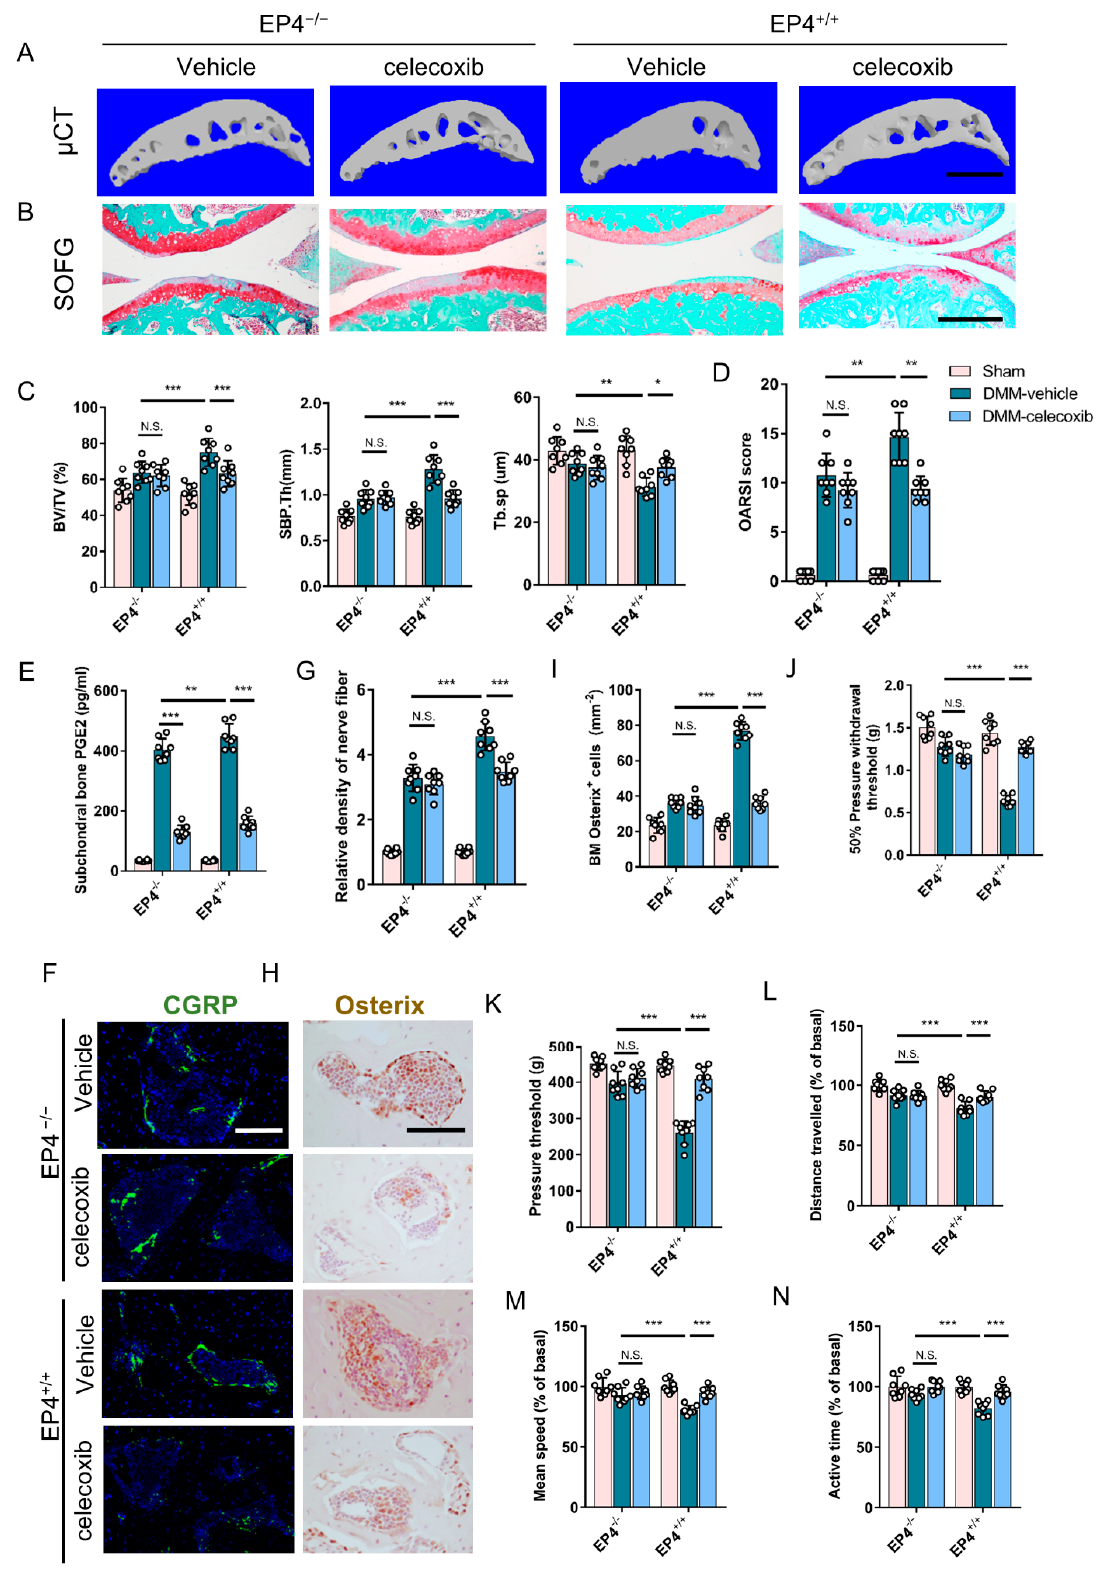
Figure 6. Conditional EP4 knockout mice are protected from aberrant subchondral bone architecture and osteoarthritis hypersensitivity. ( A ) µ CT images of subchondral bone (sagittal view) in EP4 +/+ mice and EP4 − / − (Advillin-cre-EP4) mice. Scale bar: 500 µ m. ( B ) SOFG staining of tibial